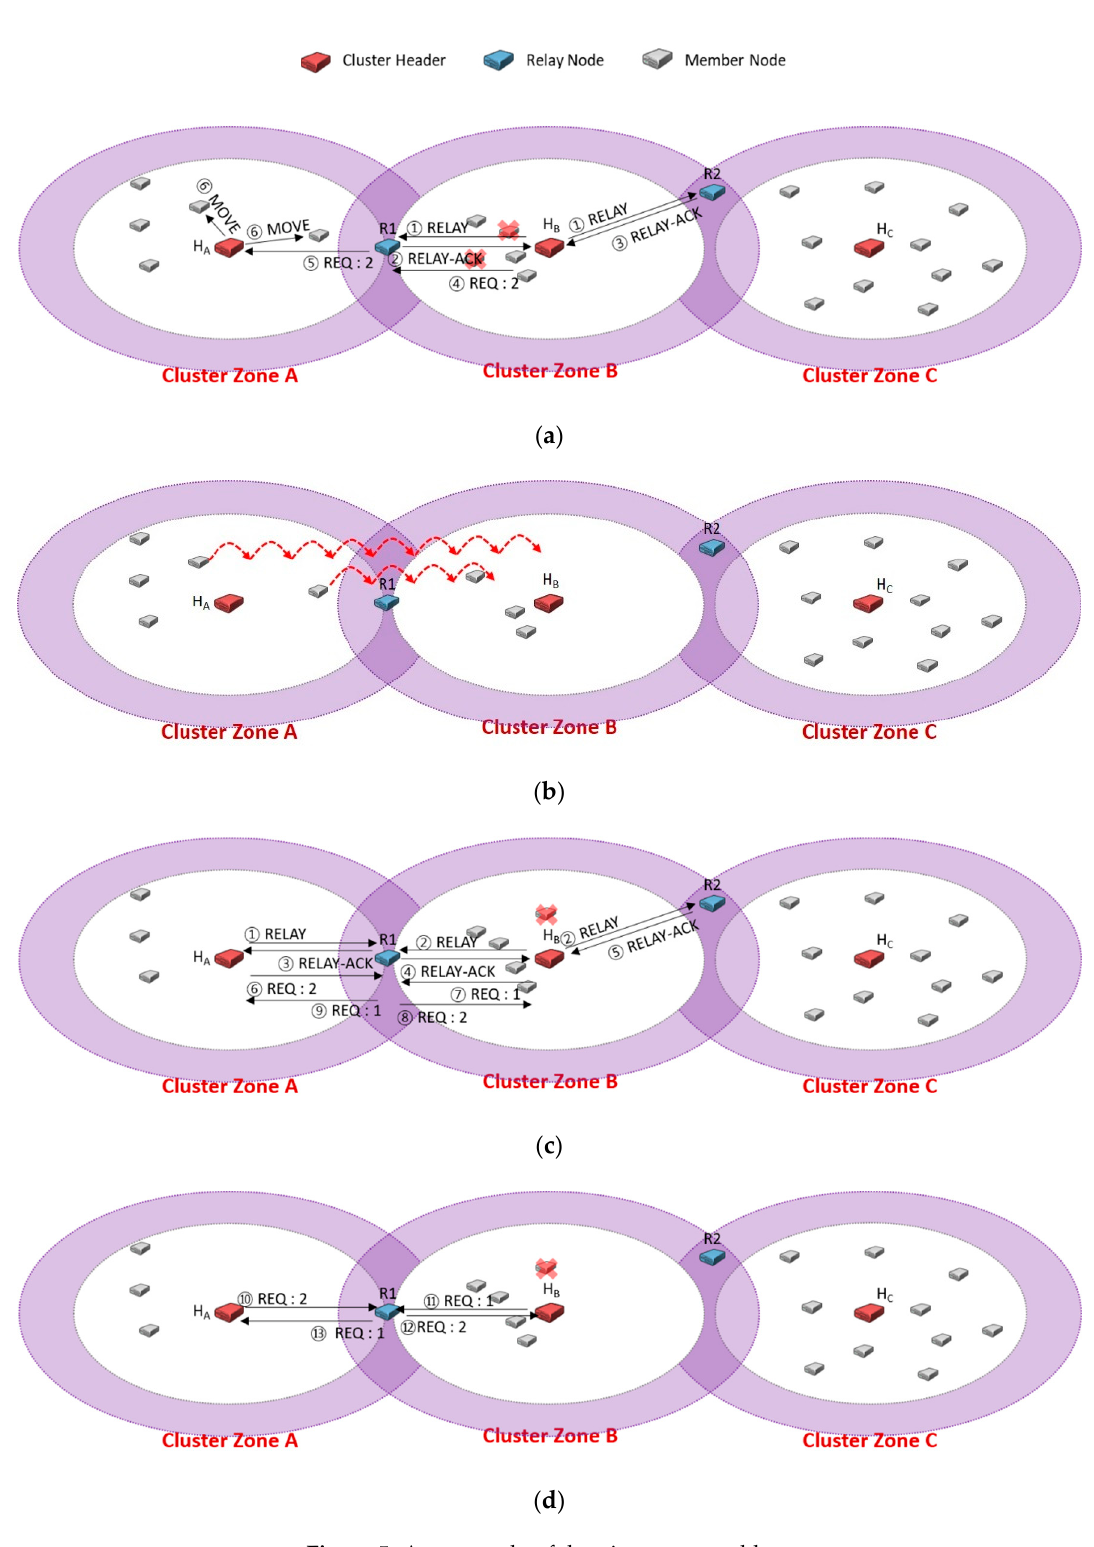
Figure 5. A case study of the ping-pong problem.